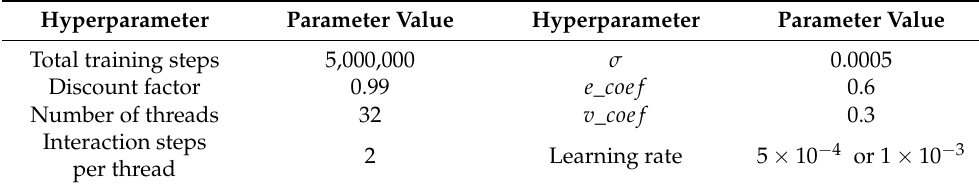
Table 3. Hyperparameter values of ACKTR.